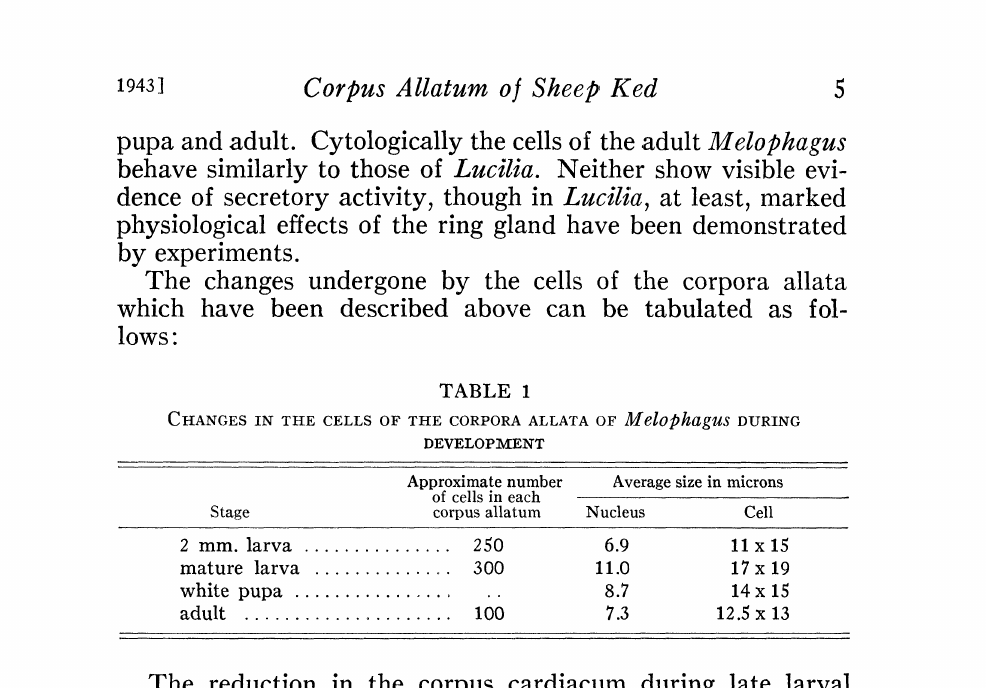
CI-IANGES IN THE CELLS OF TI-IE CORPORA ALLATA OF Melophagus DURING DEVELOP:[VIENT Approximate number Average size in microns of cells in each Stage corpus